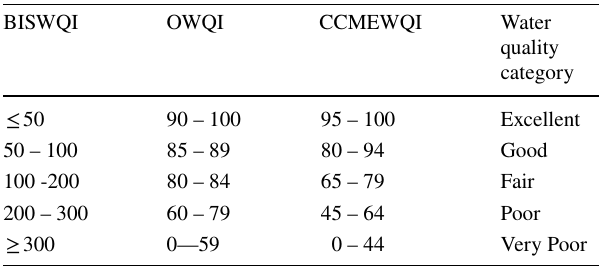
Table 6 Water quality index (WQI)